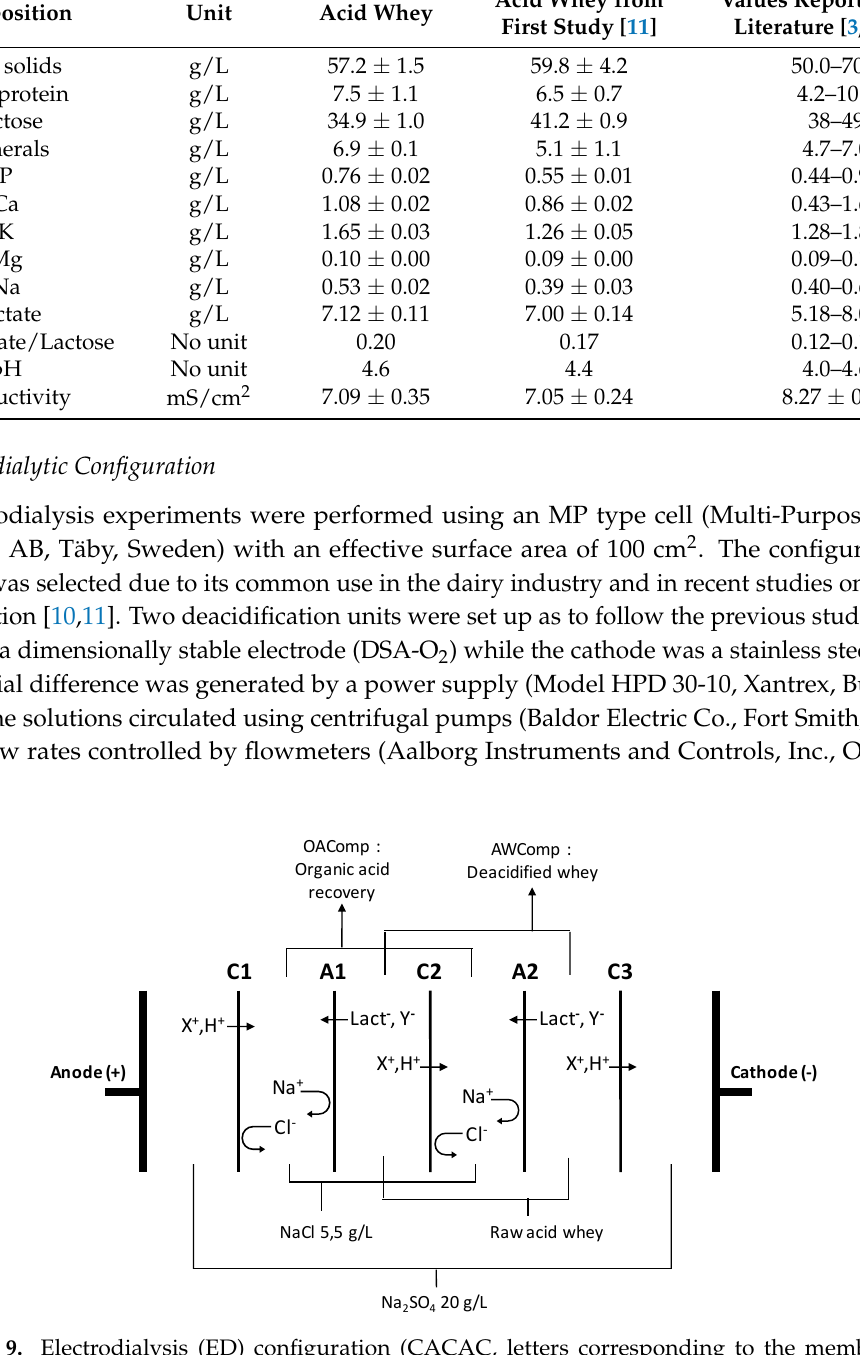
Figure 9. Electrodialysis (ED) configuration (CACAC, letters corresponding to the membrane’s stacking) used for acid whey deacidification. C refers to cation-exchange membrane and A to anion-exchange membrane. X + and Y − respectively refer to positively and negatively charged ionic species present in the whey (modified from Dufton et al. 2018 [11]).